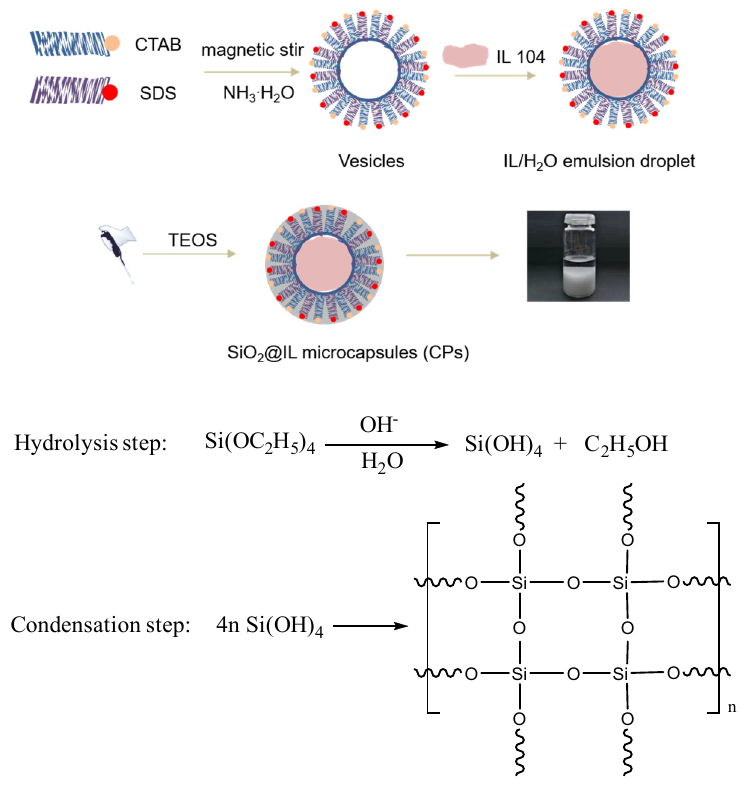
Figure 1. Different steps of the synthesis of silica microcapsules containing phosphonium ionic liquid (SiO 2 @IL).